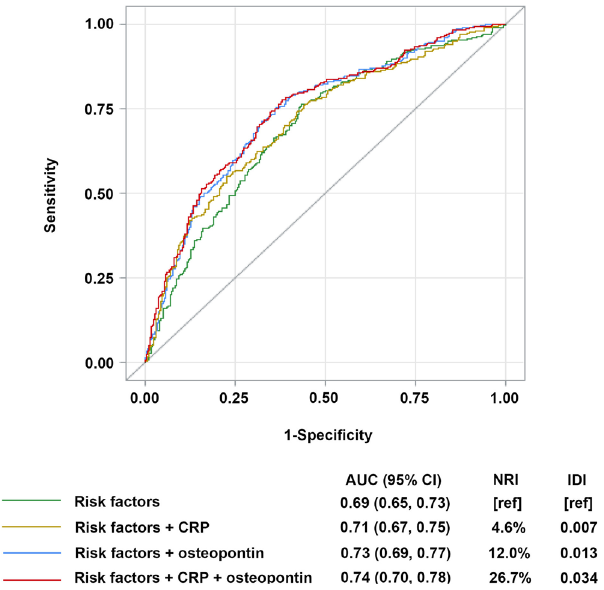
Figure 2. ROC Curve, NRI, IDI Evaluating ACS Cases and Controls in the Nested Case-control Study. The area under the curve (AUC) is shown with its 95% CIs. Traditional risk factors including age, sex, BMI, smoking status, total cholesterol, high-density lipoprotein cholesterol, systolic pressure, status of diabetes and